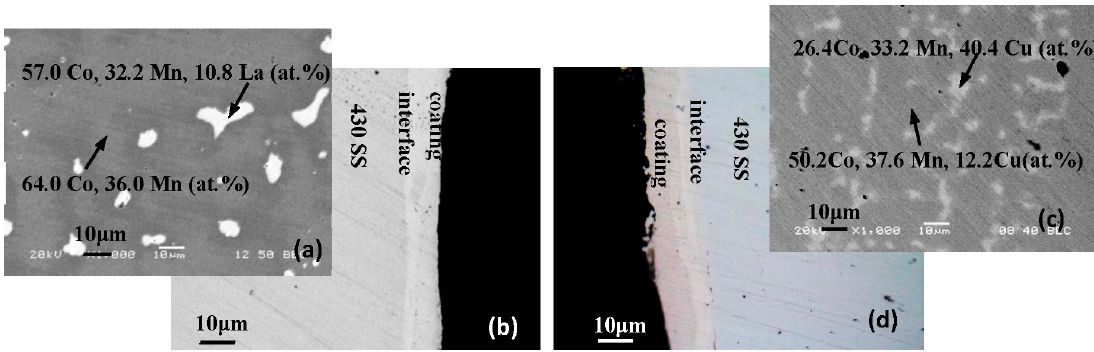
Figure 1. ( a ) Morphology of Co-38Mn-2La alloy; ( b ) cross section of Co-38Mn-2La coating deposited by high energy micro arc alloying process (HEMAA); ( c ) morphology of Co-33Mn-17Cu alloy and ( d ) cross section of Co-33Mn-17Cu coating deposited by HEMAA.